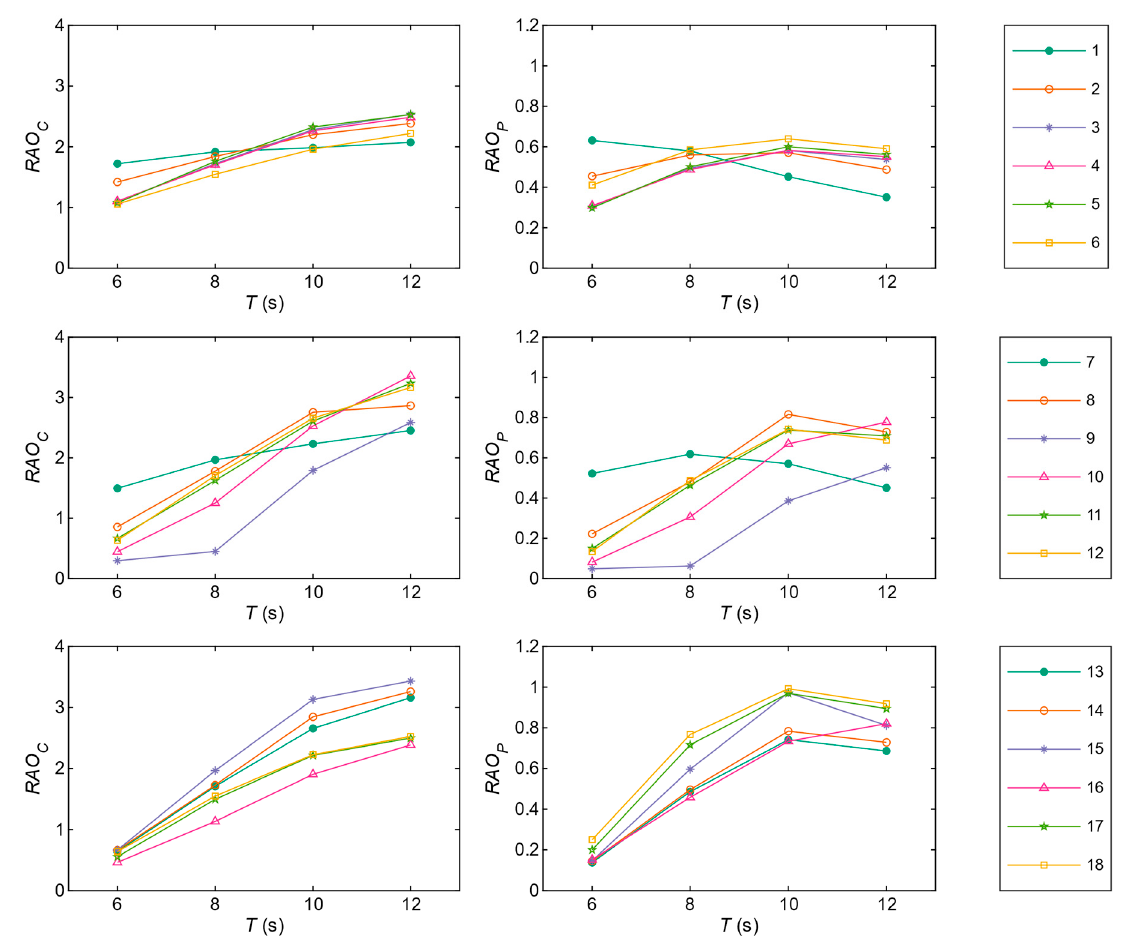
Figure 8. Variation of the response amplitude operator of the oscillations of the water column inside the chamber ( RAO C ) and the pressure oscillations ( RAO P ) with respect to the wave period ( T ) for each one of the 18 OWC model designs analyzed ( H = 1 m).